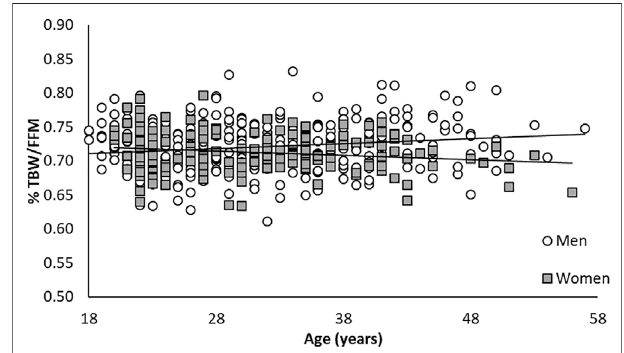
FIGURE1| Relationshipbetween%TBW/FFMacrossagesformenand women.